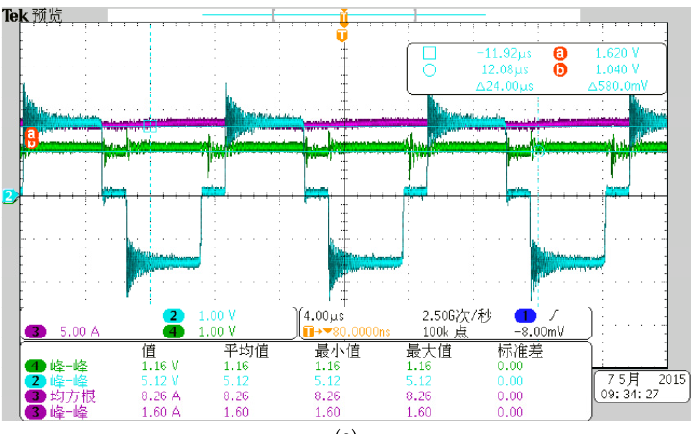
Figure 15. Cont. Figure 15. Cont.